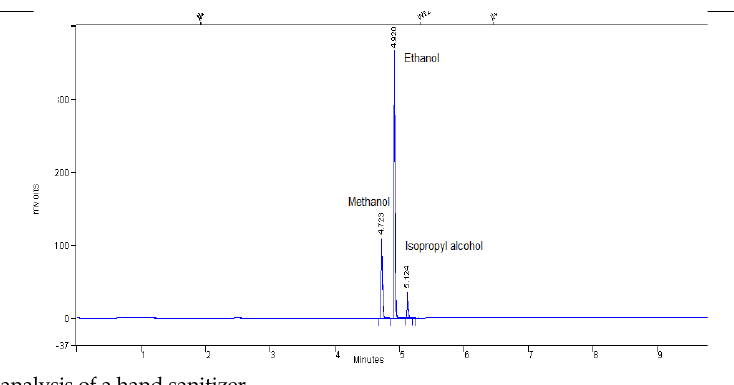
Figure 3. Qualitative analysis of a hand Fig 3. Qualitative analysis of a hand sanitizer